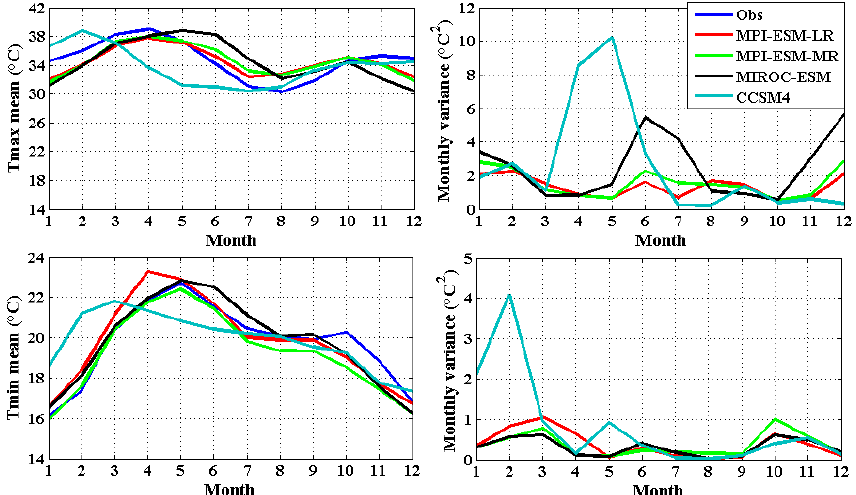
Figure 6. Comparison between the statistical properties of the observed temperature (1961–1990) and the four GCM outputs; the T max (upper panel) and T min (lower panel)